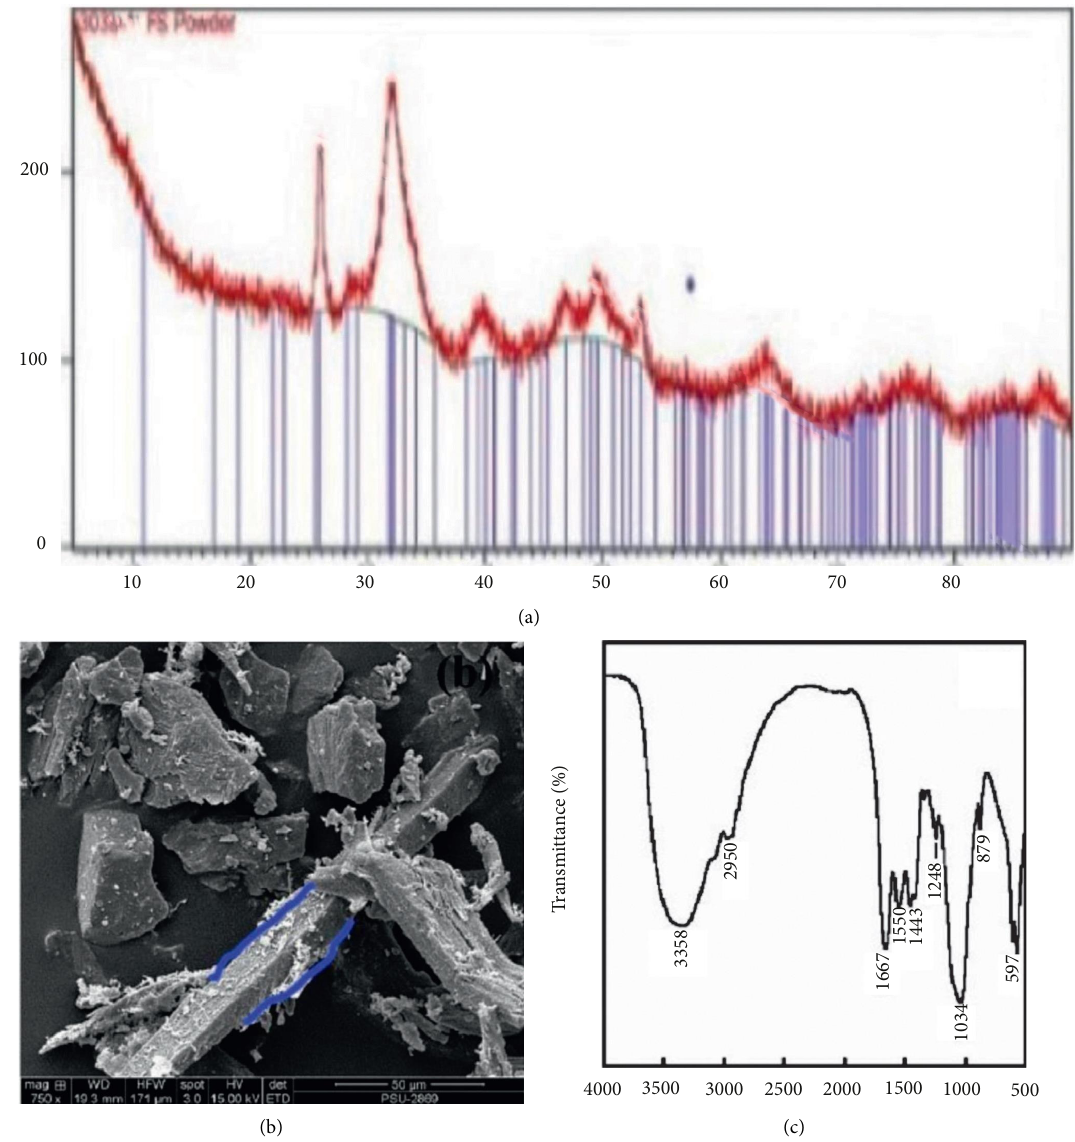
Figure 4: (a) XRD pattern, (b) SEM micrograph, (c) FTIR spectrum of the fish scale